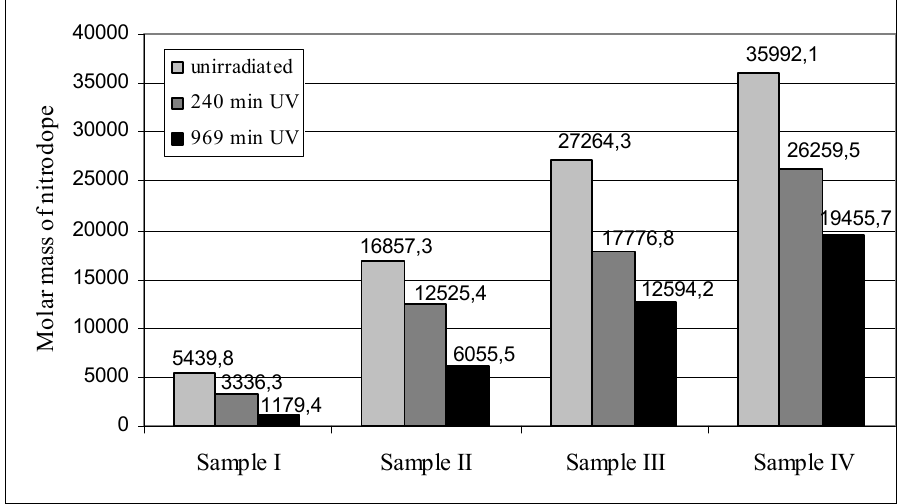
Figure 3. Collective graph of the dependence of the mean molar mass of nitrodope on the mass percentage of nitrocellulose before and after the UV